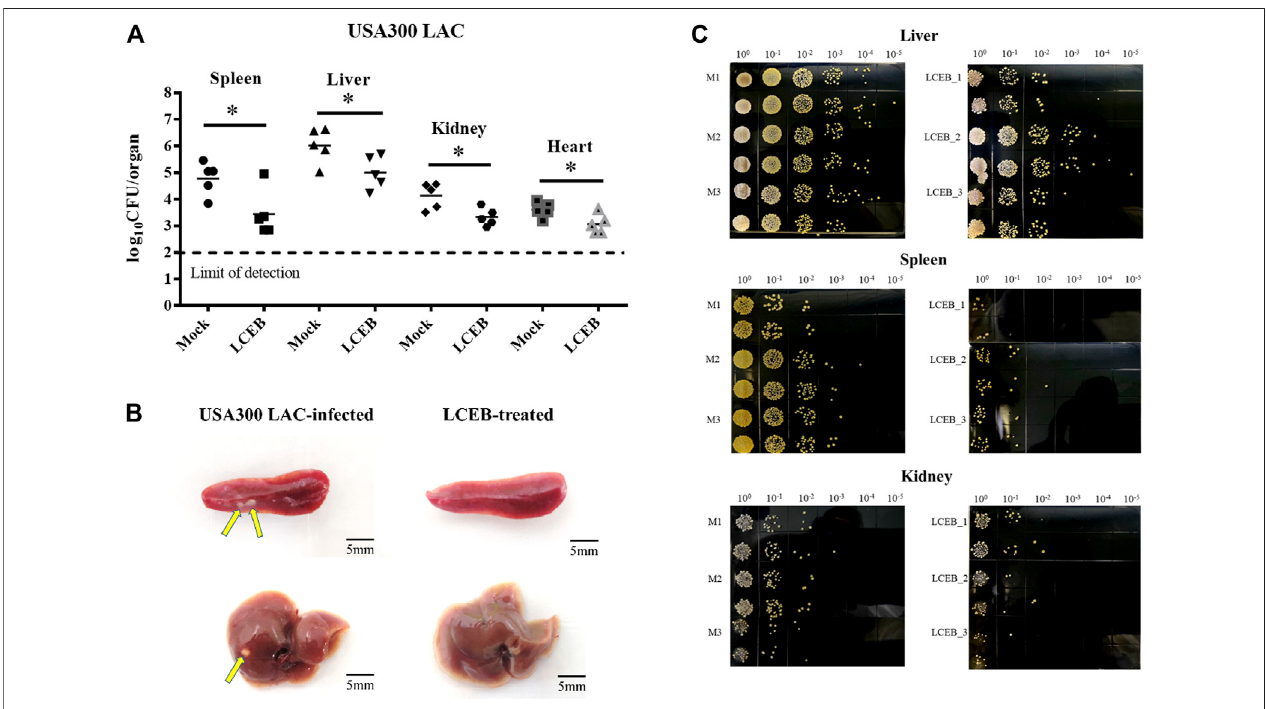
FIGURE 5 | Effect of 2 (LCEB, 10 mg/kg/d) on the survival of the S. aureus USA300 LAC strain in the spleens, livers, kidneys and hearts of mice ( n = 5) intraperitoneallychallengedwith6.1×10 8 CFUofbacteria. (A) Statisticalanalysisfortheenumerationofcolonyformingunits(CFU)isdisplayed.* p < 0.05incomparison withcontrol,Mann-Whitneytest, two-tailed.Eachsymbolrepresentsthevalueforanindividualmouse.Horizontalbarsindicatetheobservational meansandthedashed line marks limit of detection. (B) Representative photographs of USA300 LAC-infected mice spleens and livers treated with or without LCEB. (C) Representative photographs of the TSA plates for CFU enumeration of the mice livers, spleens and kidneys infected by USA300 LAC with or without treatment of LCEB.